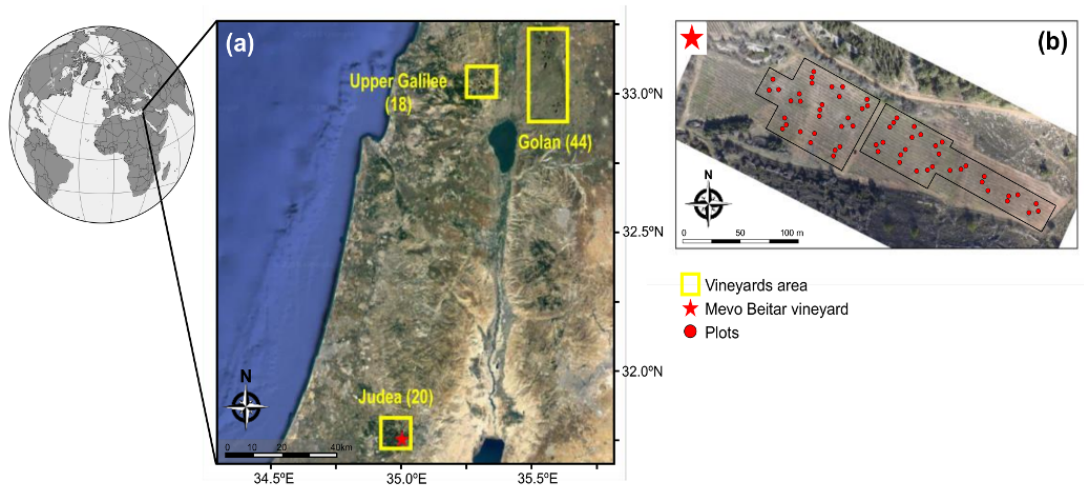
Figure 1. ( a ) Location of the three regions with the 82 vineyards used in this study shown on a Google Earth map, and ( b ) aerial photograph of the experimental vineyard at Mevo Beitar in the Judea region (location marked with a red star in ( a ). The 60 plots at Mevo Beitar vineyard in which stem water potential ( Ψ stem ) was measured in two grapevines per-plot along the 2017 growing season is shown in ( b